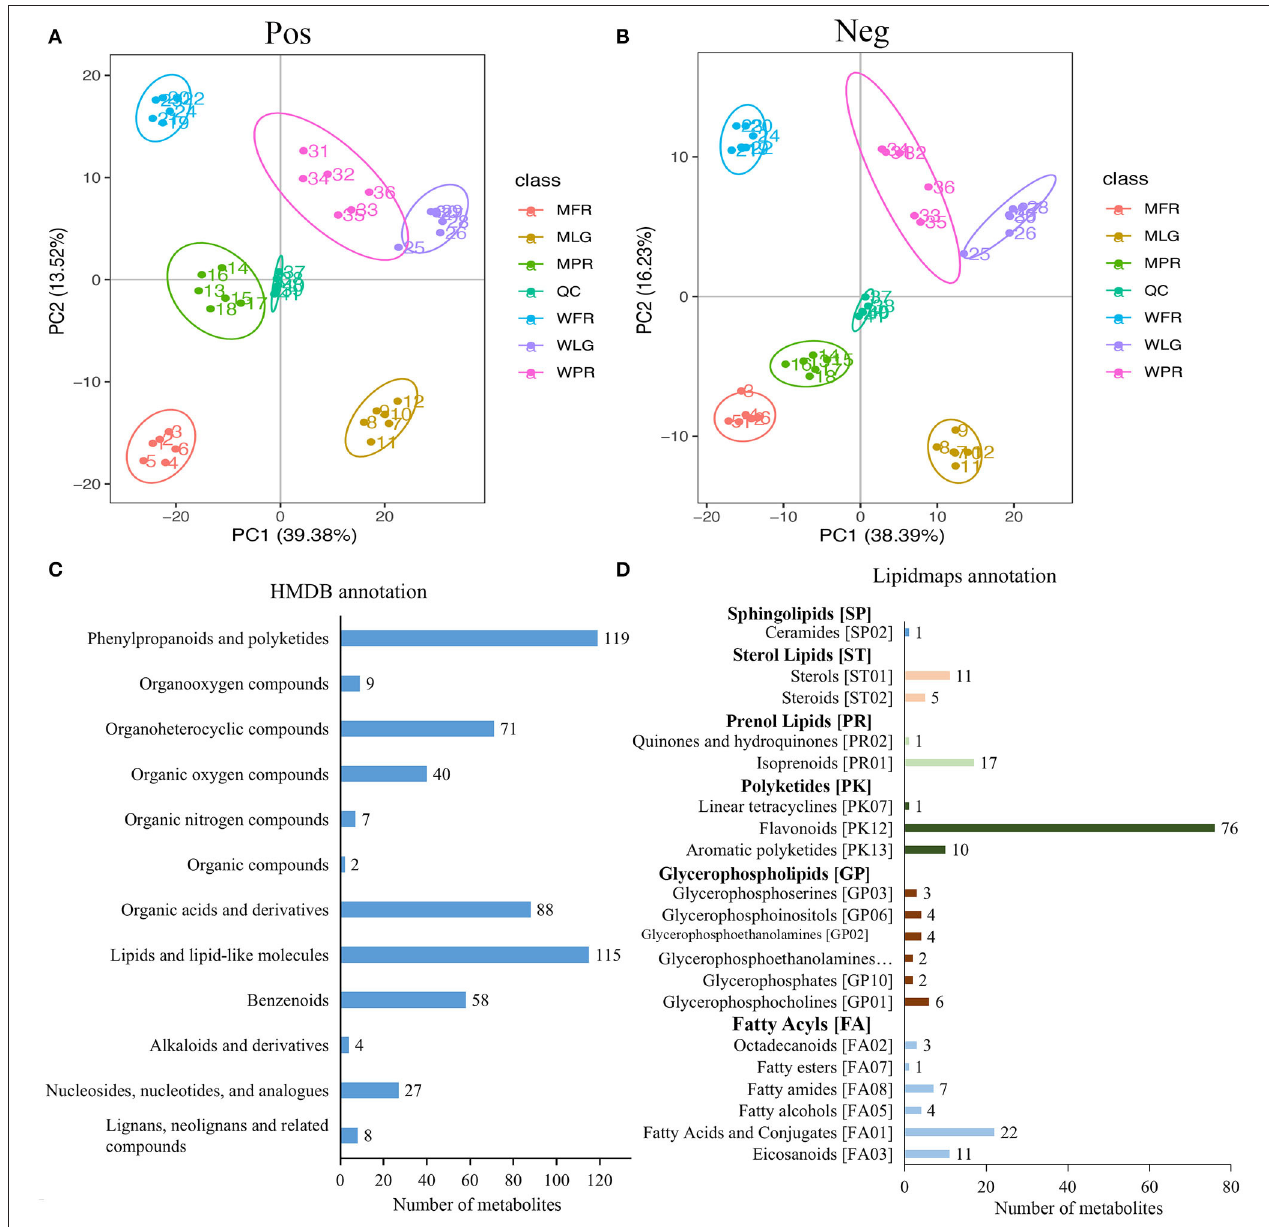
FIGURE 2 | Overall analysis of metabolome data of strawberry samples at different developmental stages. (A,B) PCA plot of metabolome data in positive and negative ion modes separately; (C,D) indicated the annotation of identified metabolites in HMDB and Lipidmaps databases. WLG, WPR, WFR indicated large green, partial red, and fully red stage of normal ‘Benihoppe’ fruits, MLG, MPR, MFR represented large green, partial red, and fully red stage of mutant fruits the same